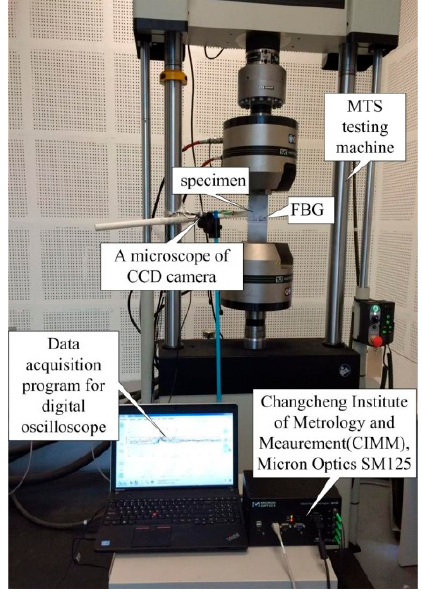
Figure 2. Experiment setup for the FBG sensor damage detection system.